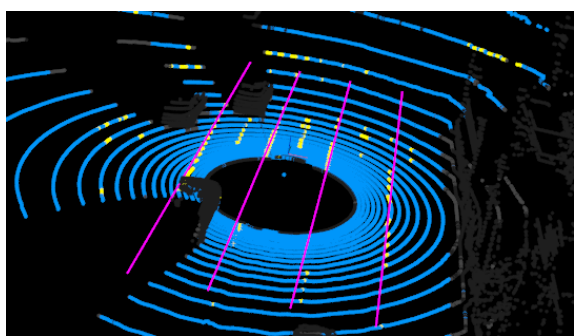
Figure 2. Example of LiDAR point categorization and the road line detection result. Blue points indicate the drivable region, yellow points the road marks including road lines and the magenta lines the detected road